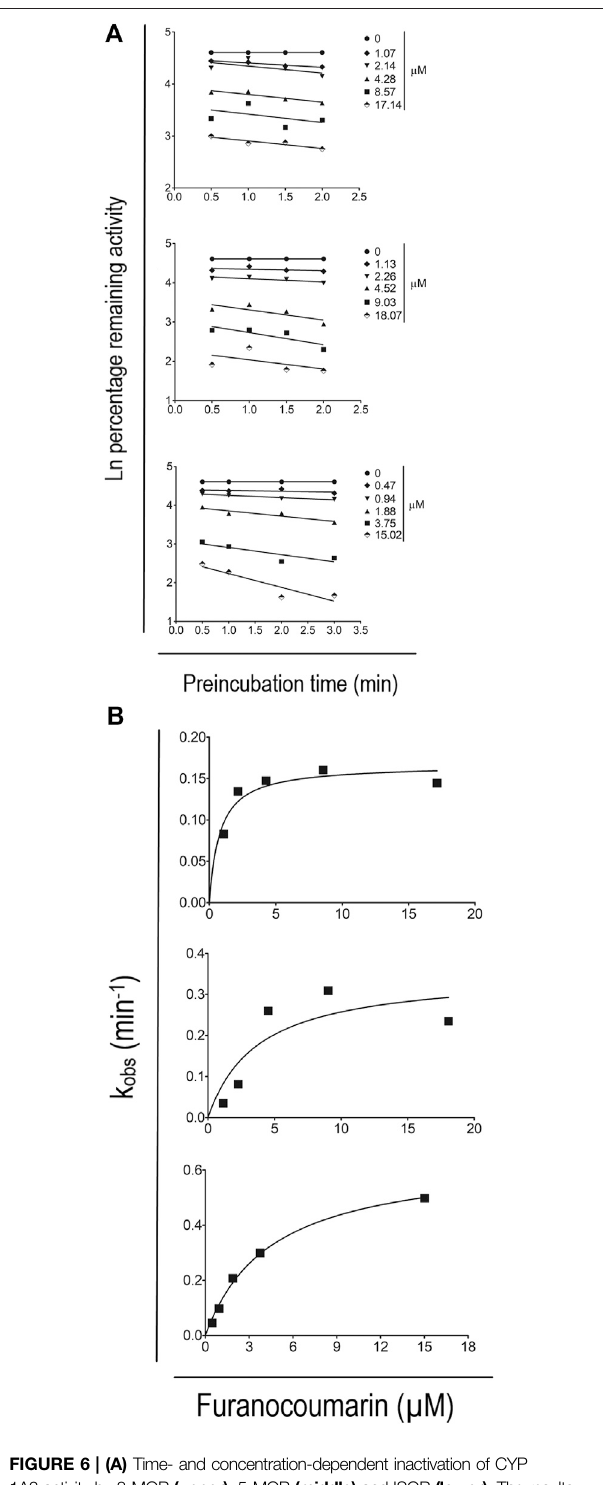
FIGURE 6 | (A) Time- and concentration-dependent inactivation of CYP 1A2 activity by 8-MOP (upper) , 5-MOP (middle) and ISOP (lower) . The results are presented as the mean of at least three independent incubations. The ± SD of the data is omitted for better display and comparison. (B) Maximum inactivation rate of CYP 1A2 activity by 8-MOP (upper) , 5-MOP (middle) and ISOP (lower) .Theresultsarepresentedasthemeanofatleastthreeindependent incubations. The ± SD of the data is omitted for better display and